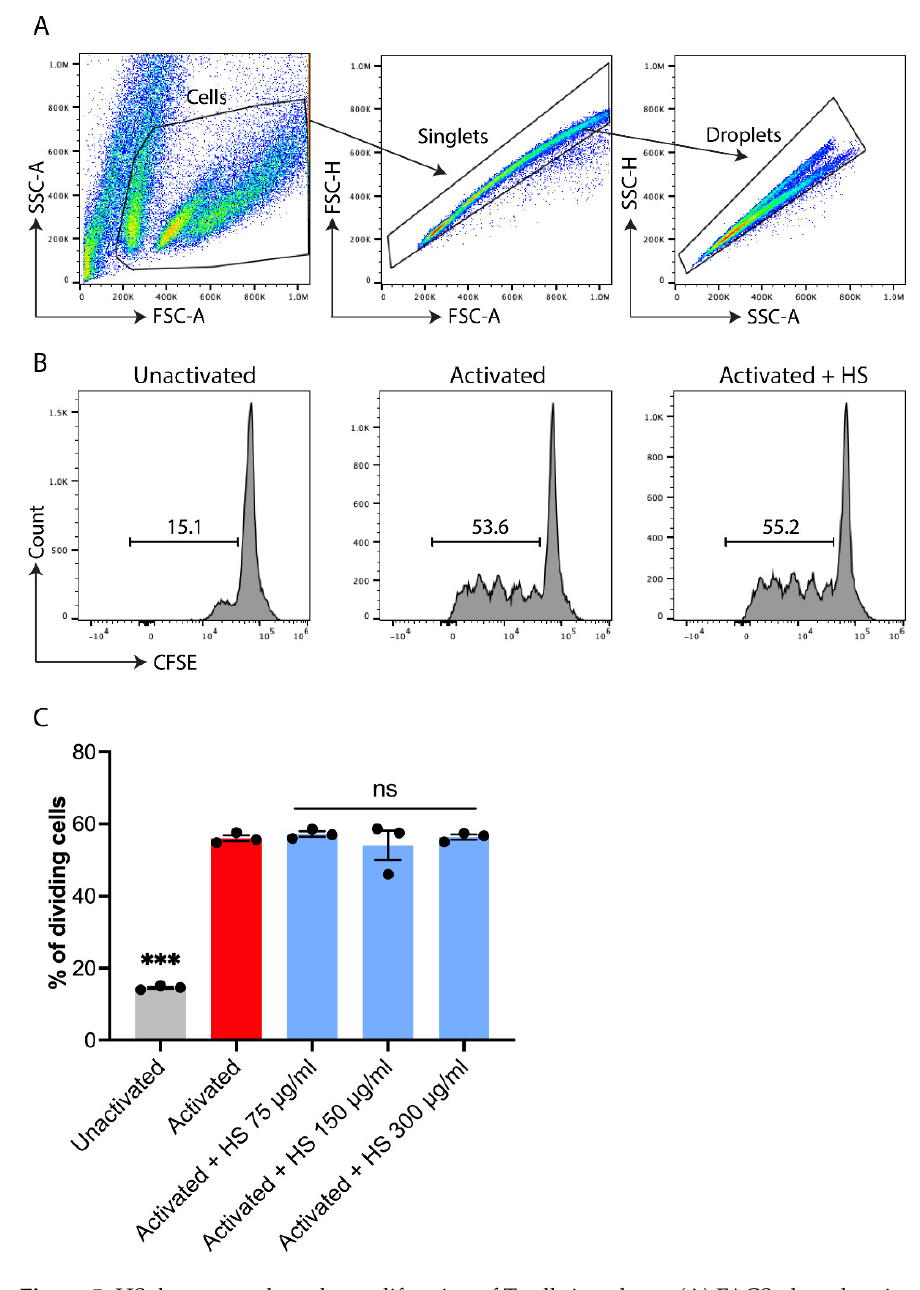
Figure 5. HS does not reduce the proliferation of T cells in culture. ( A ) FACS plots showing how the cells are evaluated. ( B ) CFSE plots where the humps to the left of the tall peak represent cycles of cell division. The % of dividing cells is also displayed. ( C ) Mean ± SEM of triplicate experiments. *** p < 0.001 (1-way ANOVA with Dunnett multiple comparisons) compared to activated controls. ns: not significant different from activated controls.